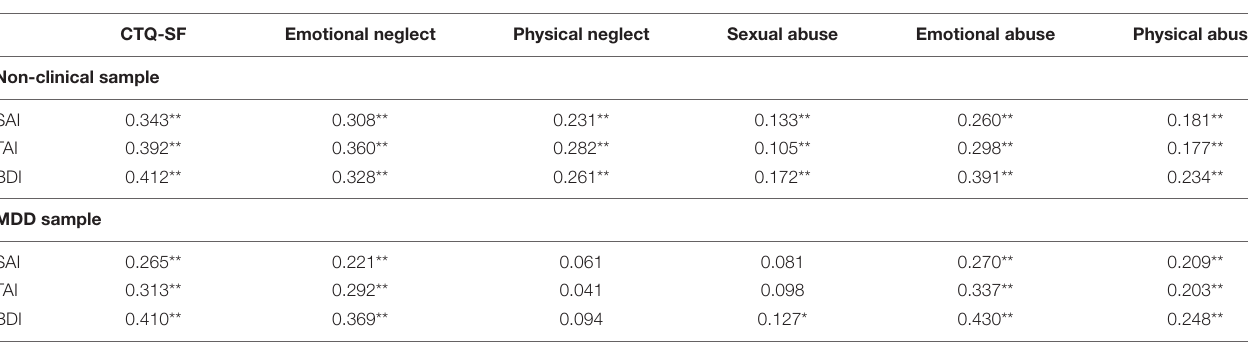
TABLE 7 | Correlations among total and subscale scores of CTQ-SF with other scales.